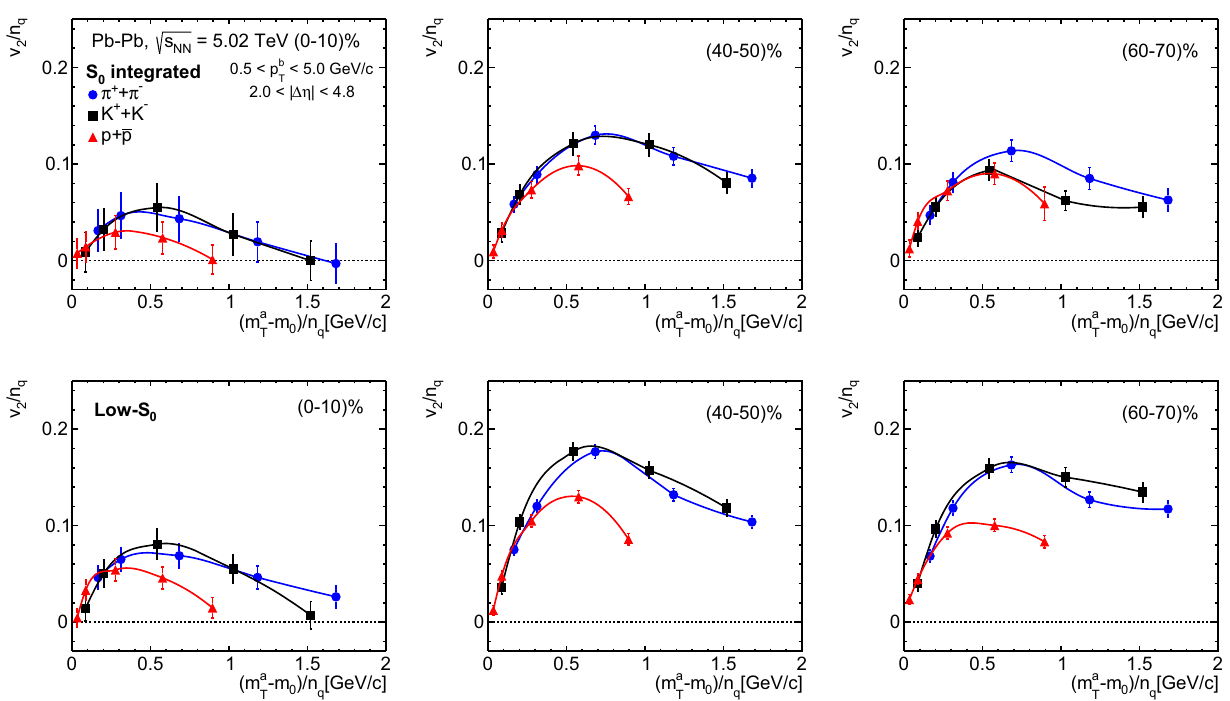
Fig. 8 Centrality dependence of elliptic flow co-efficient with trans- versemass( m T )scalingasafunctionof p a (black squares) and protons (red triangles) for spherocity-integrated